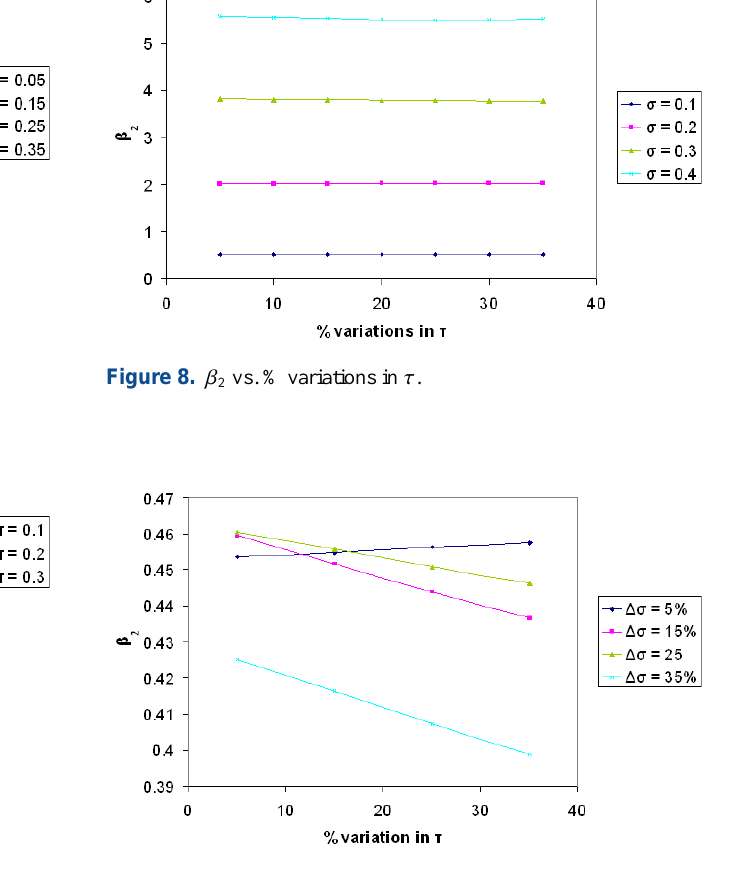
Figure 9. β 2 vs. % variations in τ and σ .